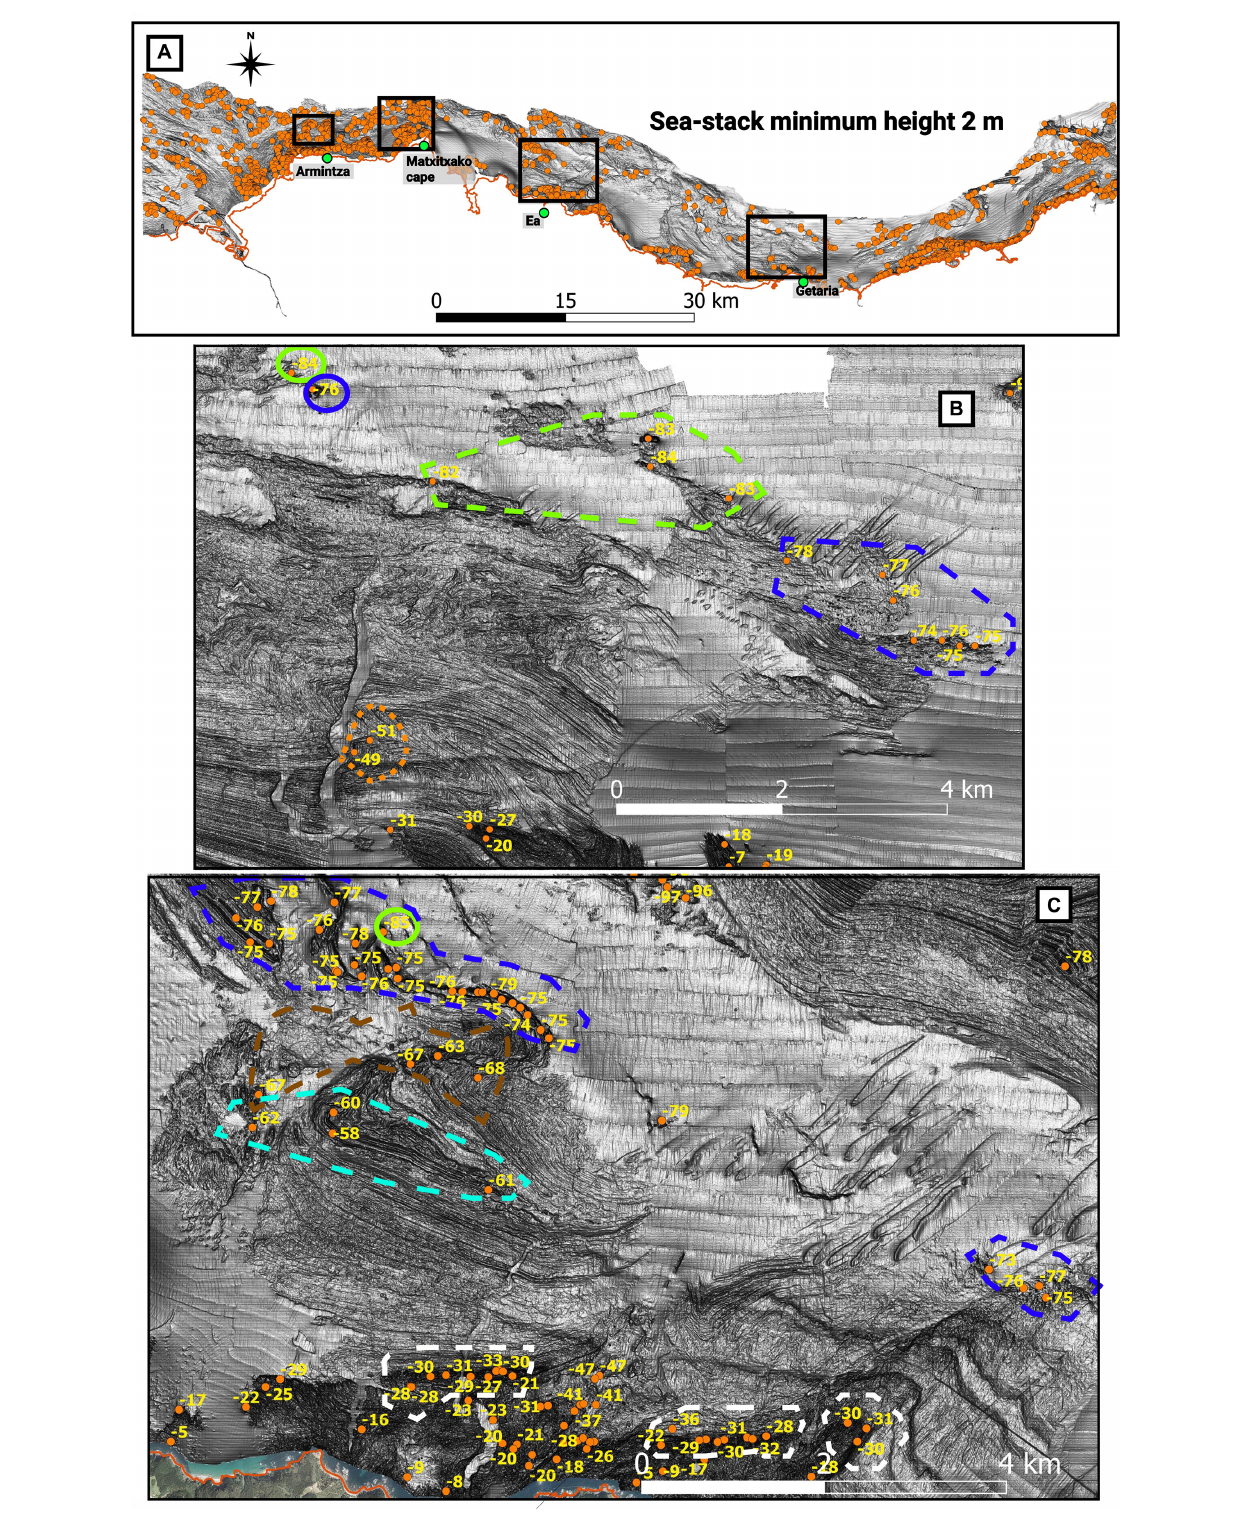
FIGURE 7 | Sea stacks distribution whose height is minimum 2 m represented by orange circles. The numbers indicate the depth of the top of the stacks. (A) Sea stacks distribution in the study area. (B) and (C) Areas in front of Getaria and Ea, respectively. Dotted lines highlight stacks that could be associated with previously detected submerged terraces. White, T2; Orange, T5; Light blue, T7; Brown, T8; Dark blue, T10; Light green, T11.